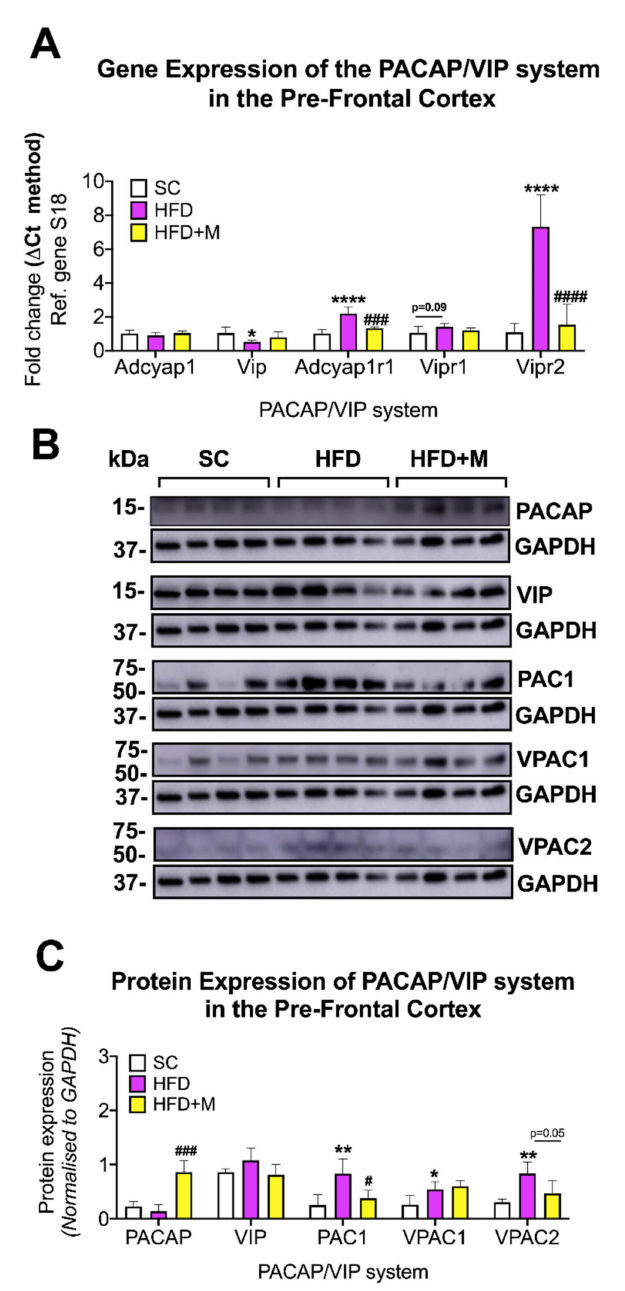
Figure 9. Gene and protein expression analysis of the PACAP/VIP system in the prefrontal cortex of C57BL/6 mice in response to HFD or metformin administration. Mice were grouped as SC, HFD, and HFD + M. Prefrontal cortices were microdissected from the left and right hemibrains from all treatment groups and were used for RNA and protein extraction with subsequent real-time qPCR and Western blot, respectively. ( A ) Differential gene expression levels of the PACAP/VIP system, ( B ) Immunoblot bands for PACAP/VIP system members were represented. ( C ) Protein expression levels of the PACAP/VIP system following normalization to the loading control, GAPDH. mRNA levels were quantified using the ∆ Ct method and normalized to the reference gene S18 (housekeeping gene). * p < 0.05 or **** p < 0.0001 vs. SC group, ### p < 0.001 or #### p < 0.0001 vs. HFD as determined by one-way ANOVA followed by Tukey post-hoc test. n = 4–8 per group. Quantification of immunoblot bands was performed using the NIH ImageJ software. Data were given as mean ± S.E.M. * p < 0.05 or ** p < 0.01 vs. SC group; # p < 0.05 or ### p < 0.001 vs. HFD group as determined by one-way ANOVA followed by Tukey post-hoc test. n = 4 per